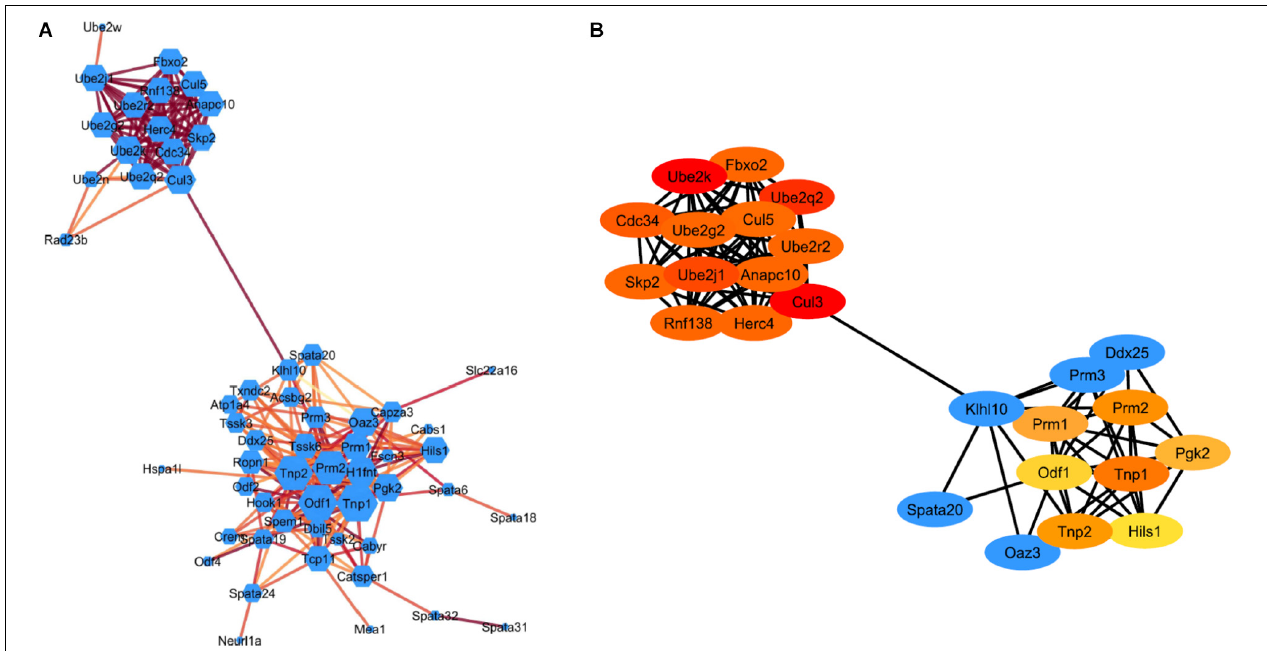
FIGURE 3 | STRING protein-protein interaction network. (A) Visualization of the PPI network of identified down-regulated DEGs from spermatogenesis process and UPP pathway. Colored nodes represent genes/proteins. Edges represent the protein-protein associations. Node size indicates node degree value and Edge color represents stringdb score. Darker edges mean higher stringdb score (B) Visualization of the top 20 hub genes from the PPI network using the cytoHubba plugin in Cytoscape software. Red to yellow colored nodes represents genes with high to low PPI degree scores.